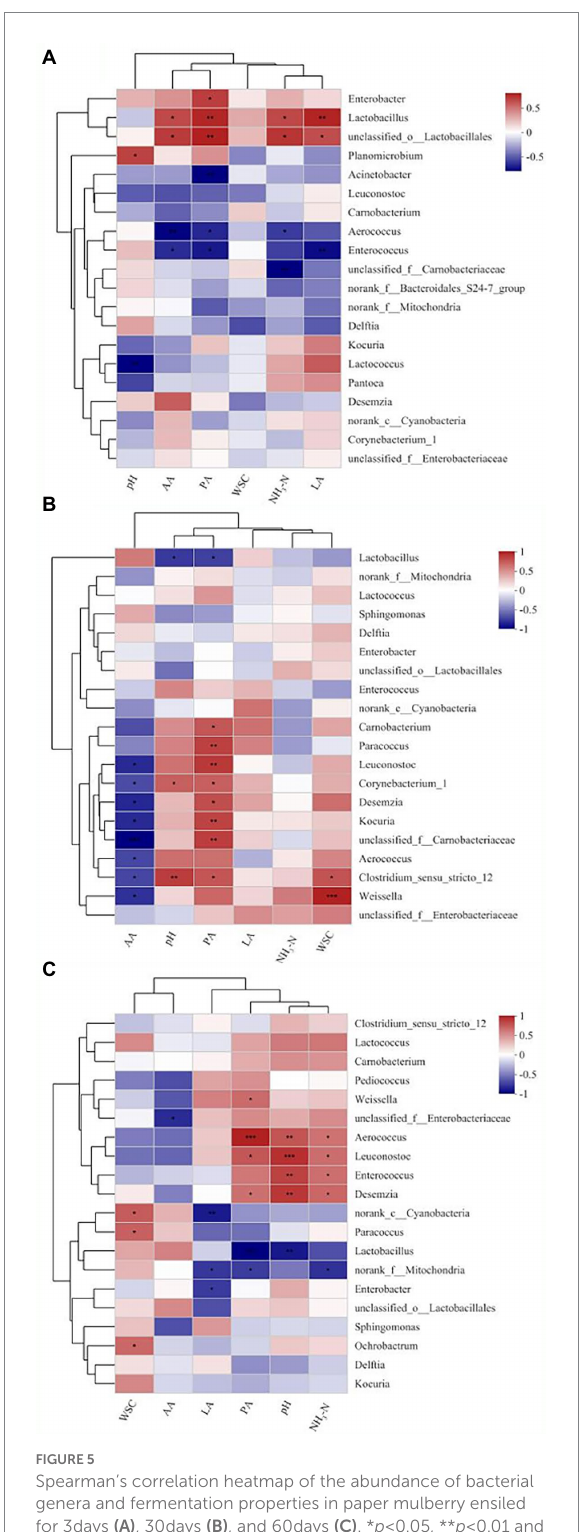
FIGURE 5 Spearman’s correlation heatmap of the abundance of bacterial genera and fermentation properties in paper mulberry ensiled for 3 days (A) , 30 days (B) , and 60 days (C) . * p < 0.05, ** p < 0.01 and *** p <